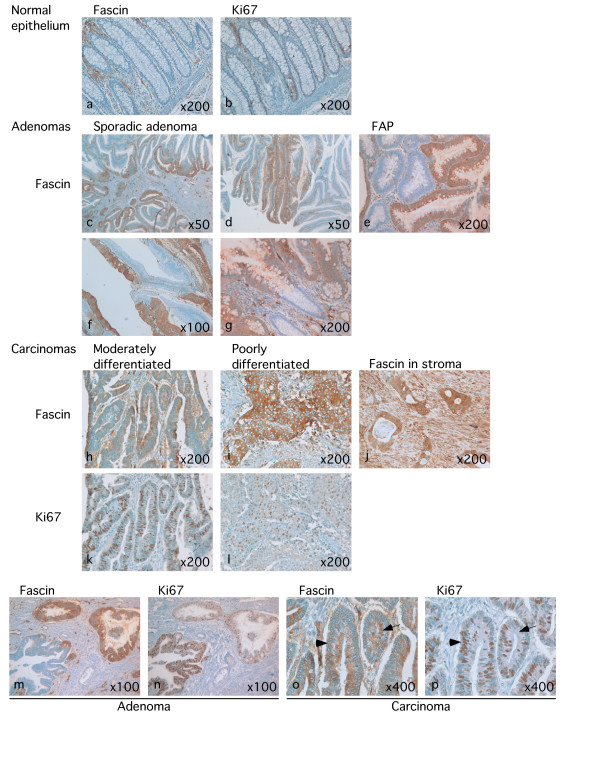
Expression of fascin and Ki67 in normal colonic epithelium, adenomas and adenocarcinomas. a, b: immunohistochemical staining for fascin and Ki67 in normal colonic epithelium. c-g: fascin staining in sporadic adenoma (c, d, f, g) and FAP (e). h-l: fascin and Ki67 staining in a moderately-differentiated adenocarcinoma, (h, k), and a poorly-differentiated adenocarcinoma, (i, l). j: stromal staining of fascin in a colorectal adenocarcinoma. m-p: representative examples of fascin, (m, o), and Ki67 staining, (n, p), in continuous sections from a sporadic adenoma, (m, n), and a moderately-differentiated adenocarcinoma, (o, p). Arrows in o and p indicates examples of areas where fascin and Ki67 are inversely correlated; arrowheads indicate areas where staining is over-lapping.